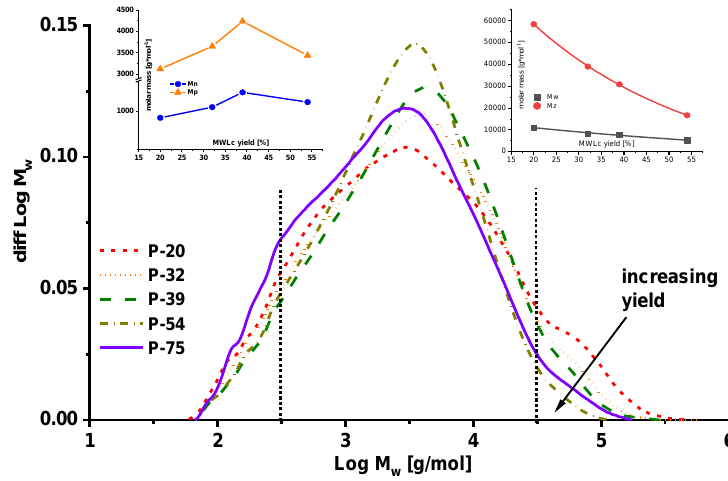
Figure 2. Molar mass distribution in relation to the crude lignin yield. Inserts: Corresponding statistical moments M n and M p ( left ) and M z and M w ( right ).